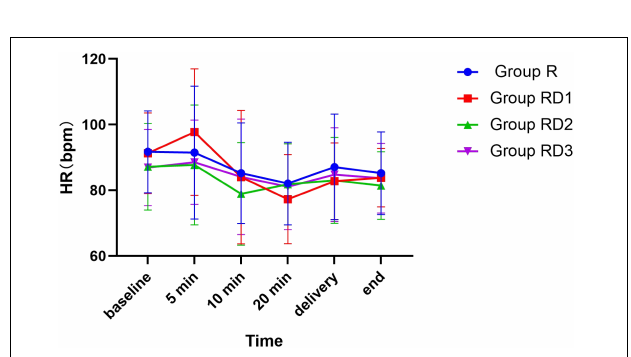
FIGURE 3 | Heart rate (HR) among the four groups. No significant differences were noted between the groups.